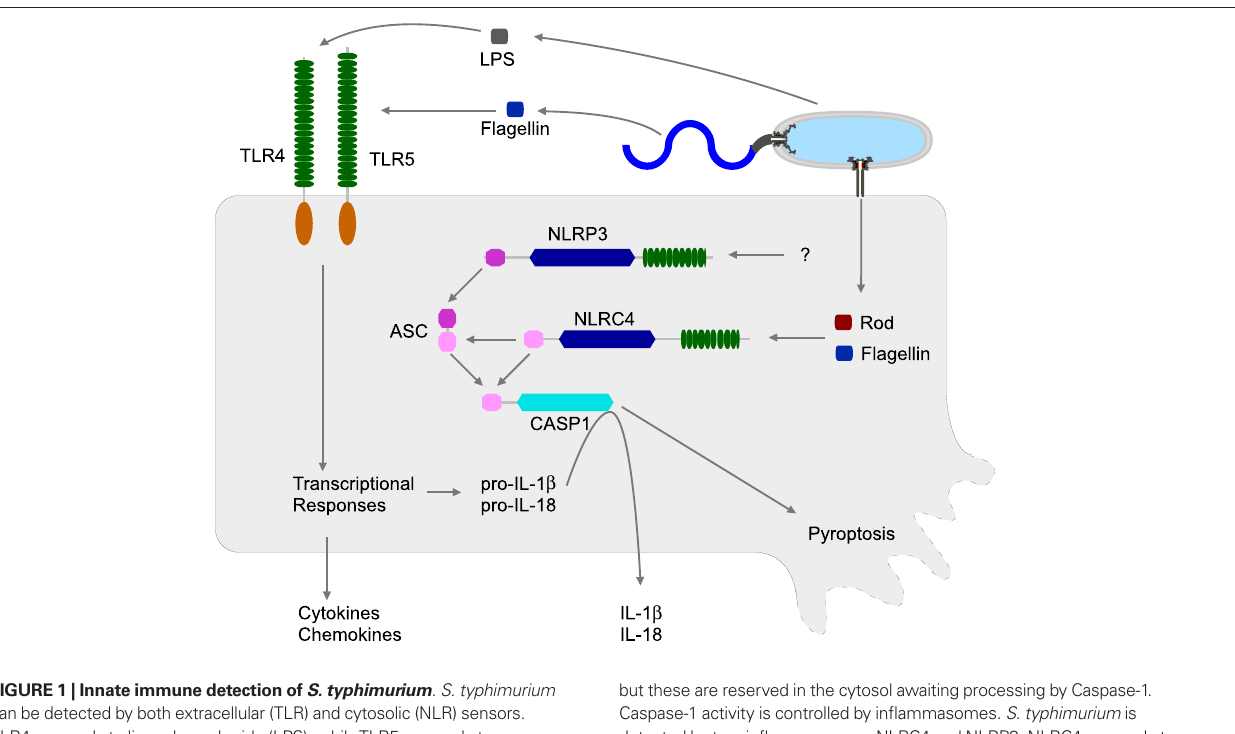
FIgure 1 | Innate immune detection of S. typhimurium . S. typhimurium can be detected by both extracellular (TLR) and cytosolic (NLR) sensors. TLR4 responds to lipopolysaccharide (LPS), while TLR5 responds to extracellular flagellin monomers. TLRs induce transcriptional responses, including the synthesis and secretion of multiple cytokines and chemokines. TLRs also induce the synthesis of pro-IL-1 β and pro-IL-18,